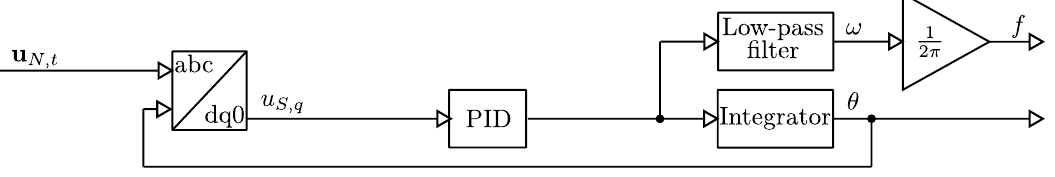
Figure 5. Grid synchronization of Figure 4 realized as SRF-PLL.